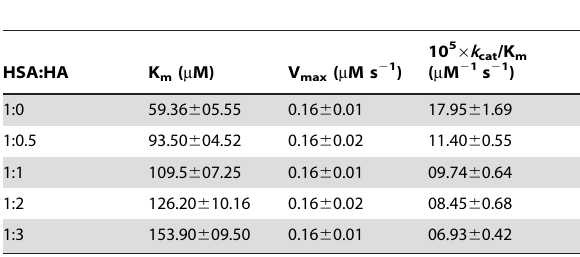
Table 4. Kinetic parameters for the hydrolysis of p -NPA by